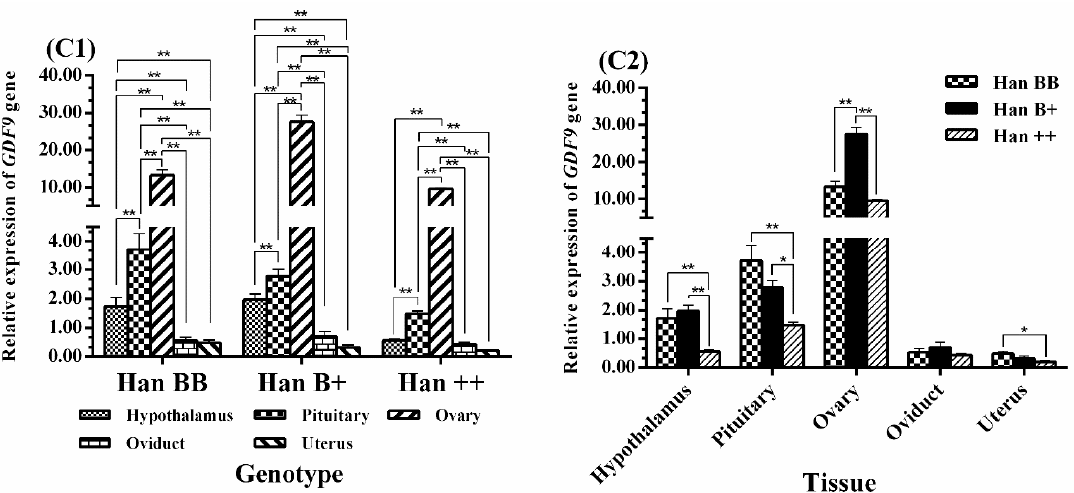
Figure 5. Comparison of expression of GDF9 among three FecB genotypes ( C1 ) and among tissues ( C2 ). Means with different superscripts are significantly different. The significant results with a p -value lower than 0.01, 0.05 are giving two asterisks (**) and one asterisk (*), respectively. Nonsignificant results are not giving any asterisks.